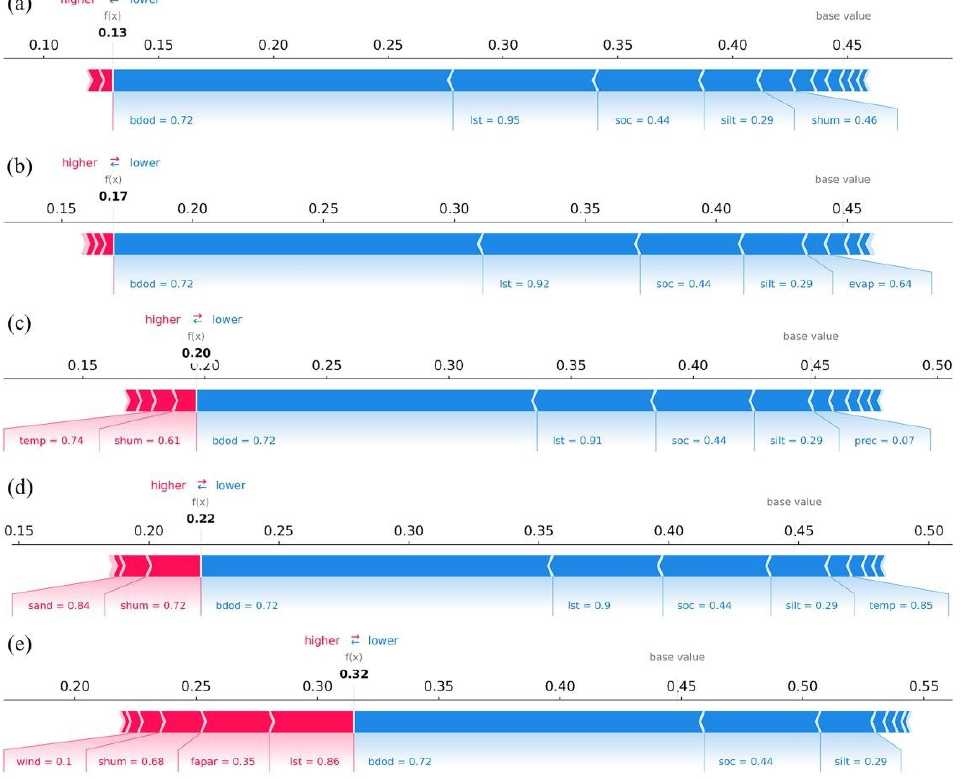
Figure 10. The individual force plots at the BJ station for different drought conditions: ( a ) extreme drought on 06 August 2006, ( b ) severe drought on 28 May 2013, ( c ) moderate drought on 11 June 2015, ( d ) abnormal drought on 27 June 2012 and ( e ) nondrought on 19 September 2012.